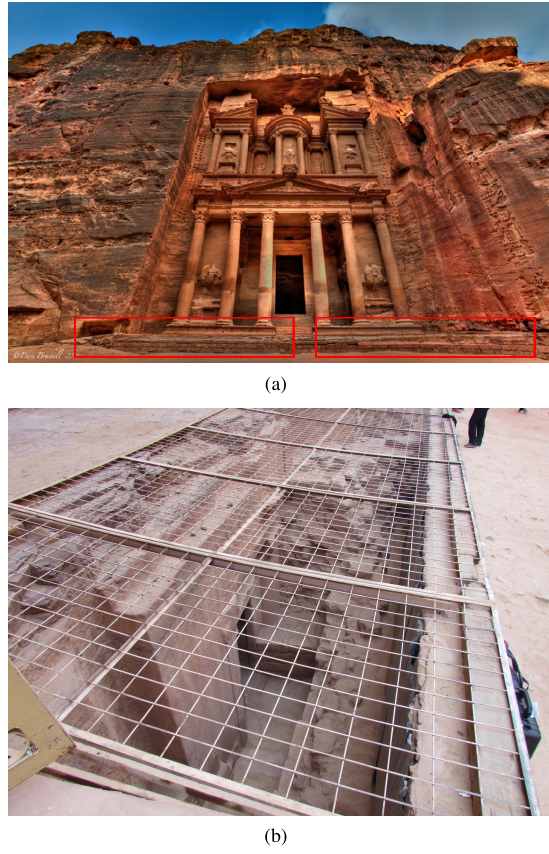
Figure 1. The Treasure of the Pharaoh. (a): El-Khasneh fac¸ade with highlighted at its bottom the iron grid covering the conveived doors. (b): the entrance doors of the excavation area, under the main building.